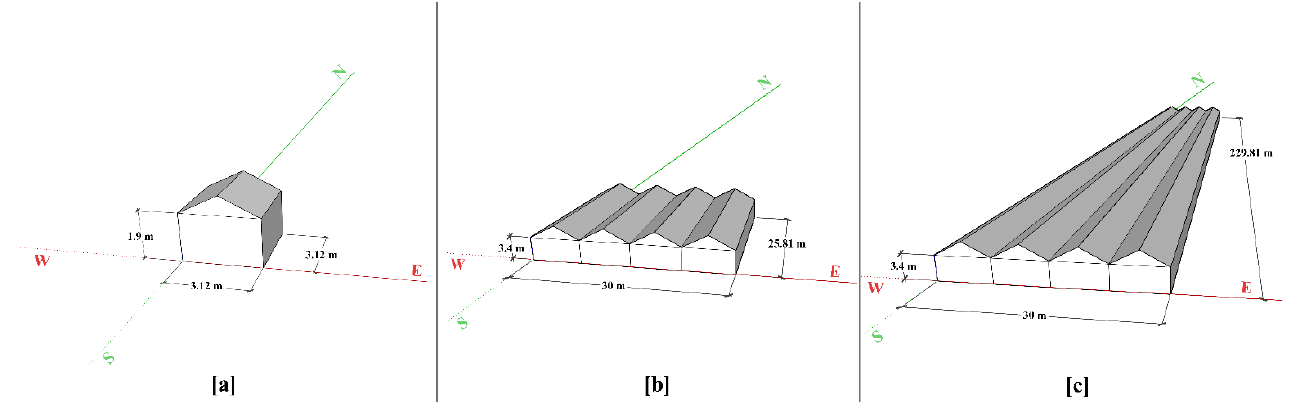
Figure 9. The technically feasible greenhouses for each miner scenario ( a ) 1st scenario; ( b ) 2nd scenario; ( c ) 3rd scenario in London, ON.